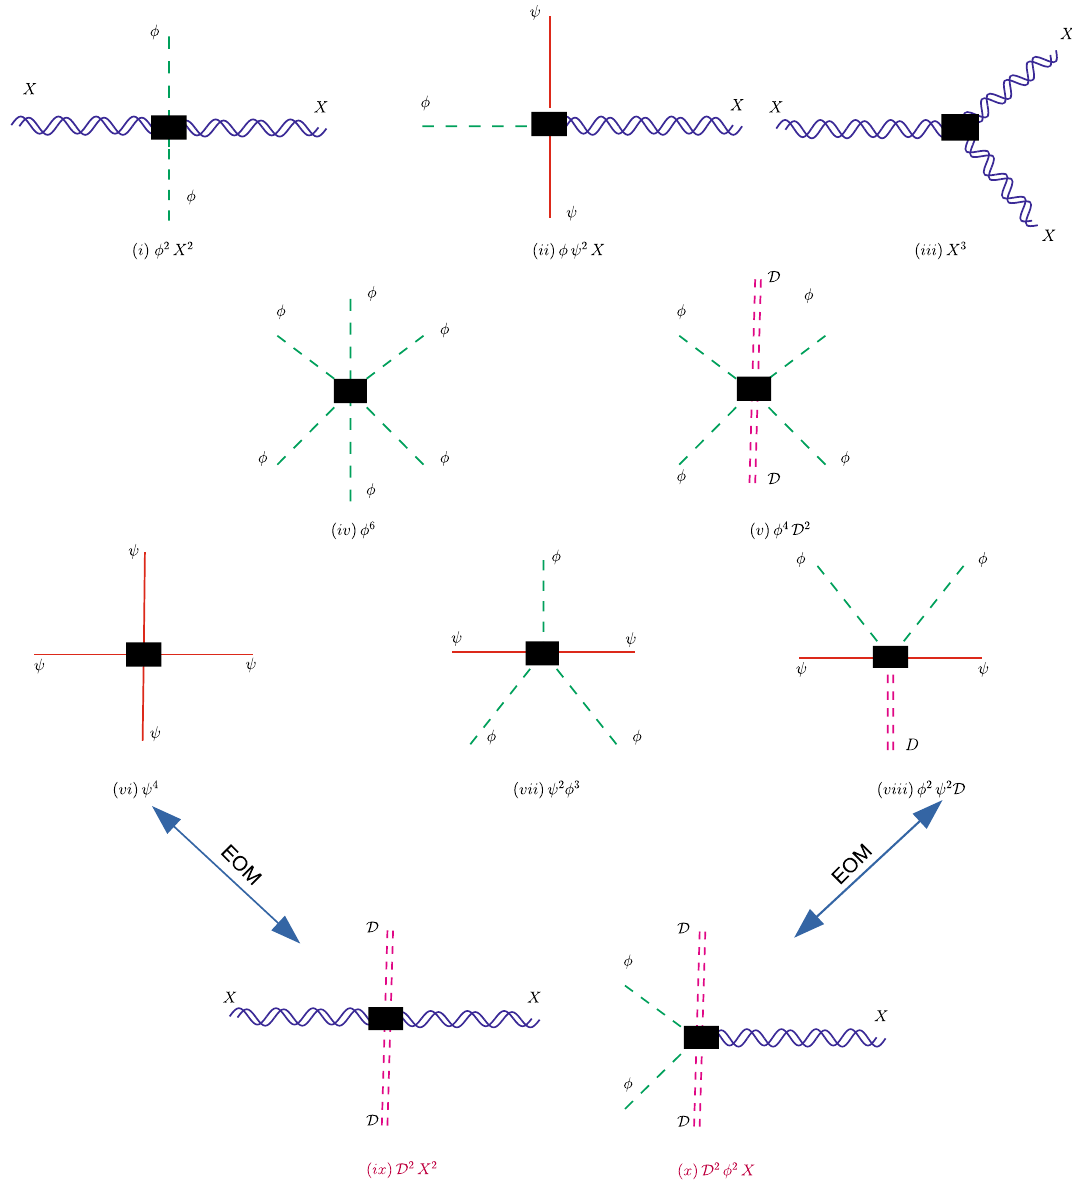
set we have two popular operator bases. The Warsaw basis [6] includes the operator classes ( i ) − (v iii ) and forms a complete set. While, the SILH [7] basis trades off ( ii ) , (v i ) − (v iii ) (the operators composed of fermionic fields) in favour of (ix) and (x) , This forms an under-complete